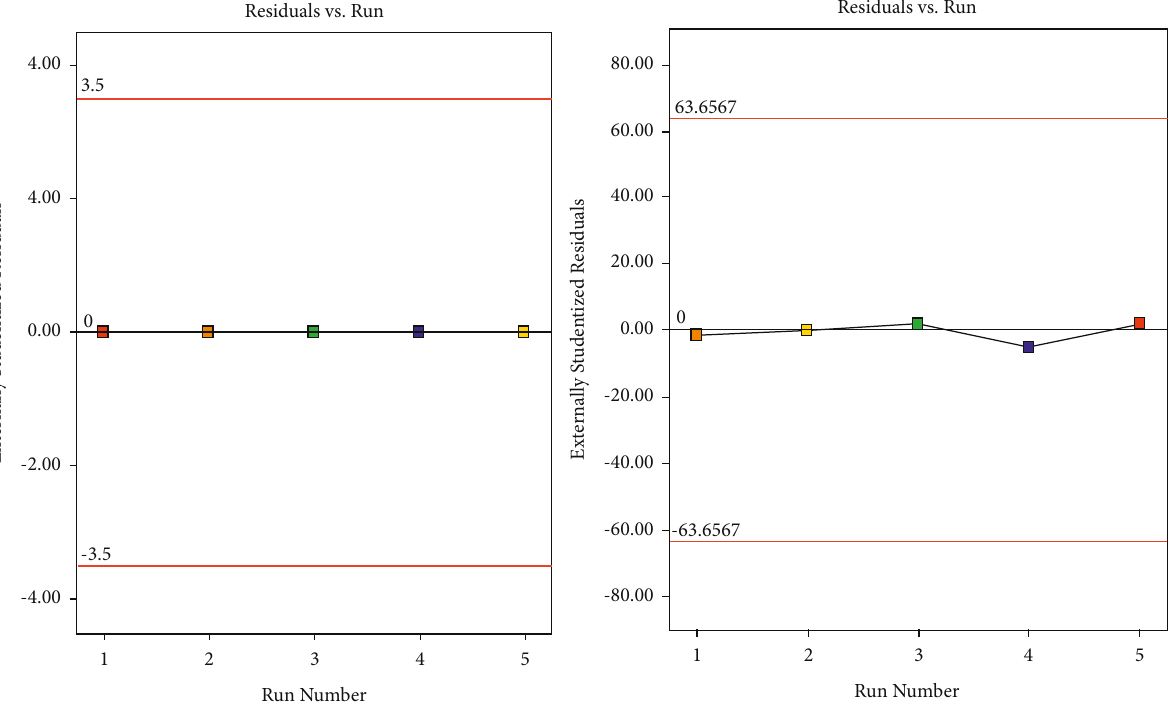
Figure 10: Residual vs. experimental run diagnostic graphs.